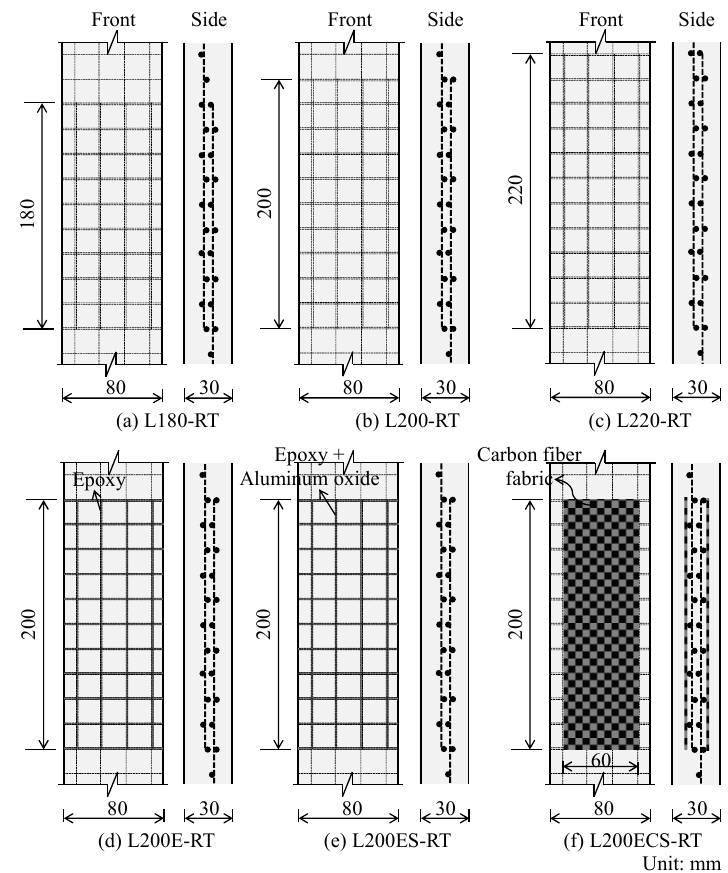
Figure 3. Details in lap splice area.